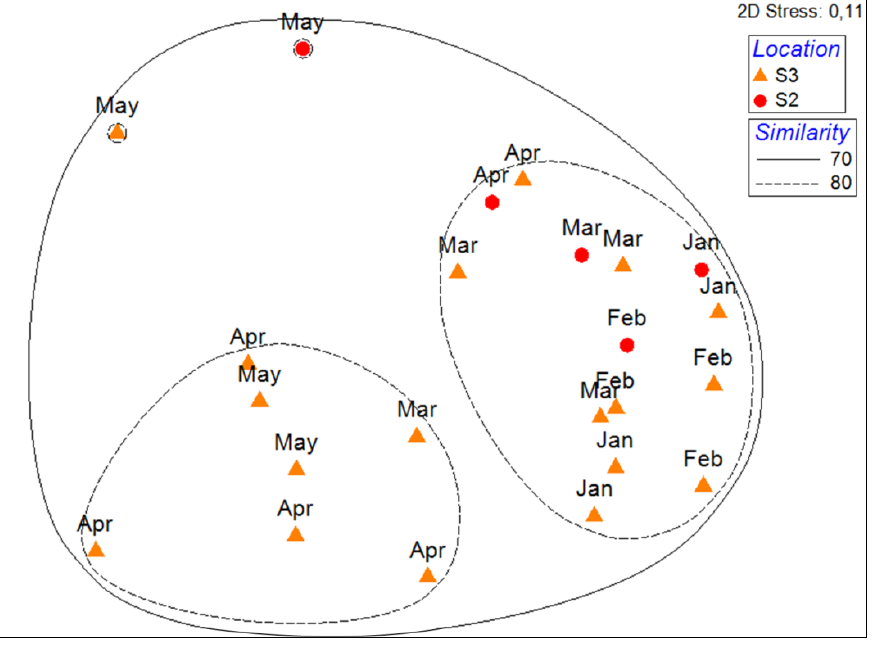
Figure 2. MDS of pigment composition of phytoplancton assemblages in S2 (Bastia, sampling station located 1 km offshore, in red) and S3 (Bastia, near the coast, in orange) coupled to a cluster analysis. Solid and dashed lines represent the principal clusters identified at respectively a 70 and 80% Bray Curtis